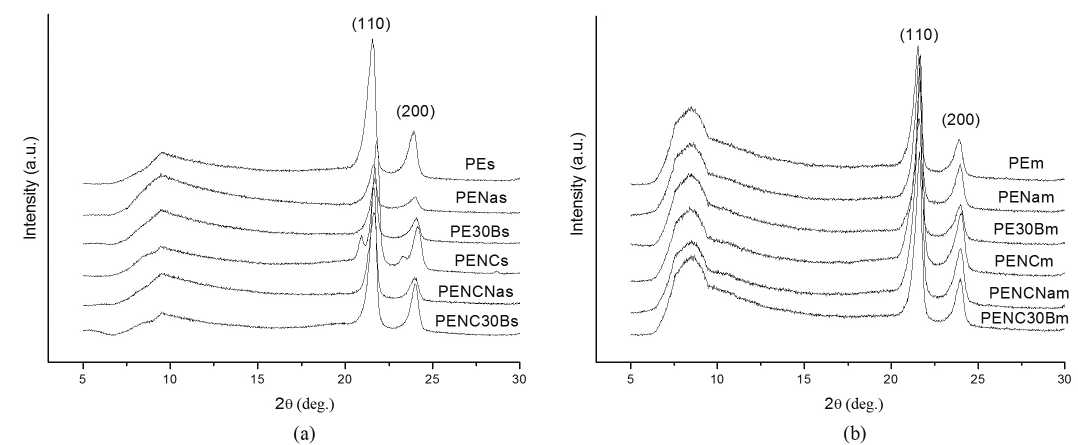
Figure 3. X-ray diffraction patterns of PE and nancomposites for (a) solution (b) melt intercalation.